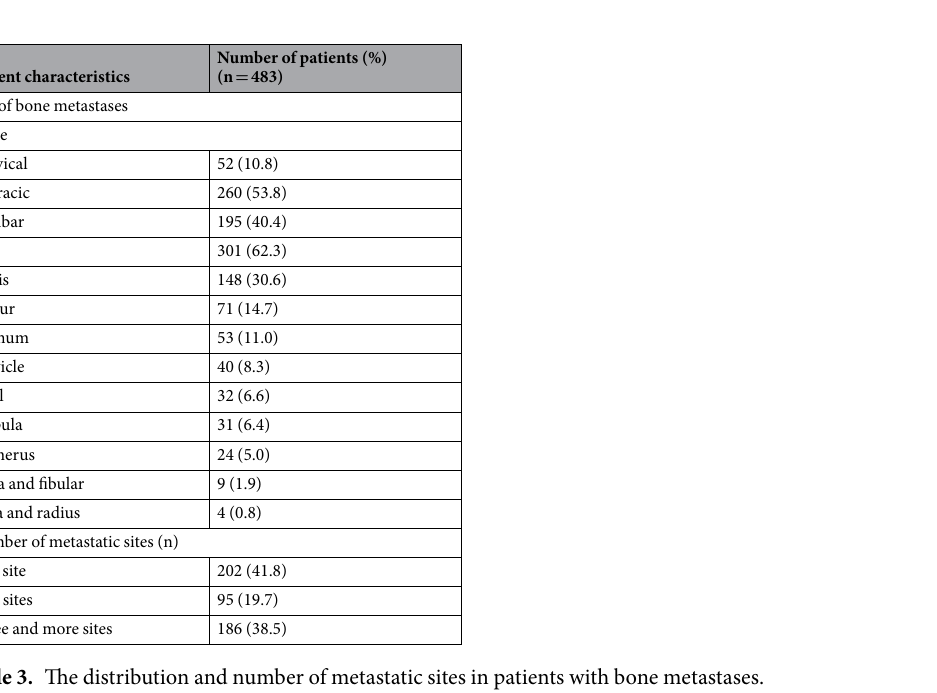
Risk factors for bone metastases in patients with lung cancer. In order to identify the risk fac- tors for bone metastases in patients with lung cancer, the clinical factors were compared between patients with and without bone metastases (Table 2). Significant differences were found for patients’ age, histopathologic type and the concentrations of CA-125, CA-199 and ALP between the two groups. Binary logistic regression analysis additionally indicated that histopathologic type (OR = 1.160, P = 0.002), the concentration of CA-125 and ALP